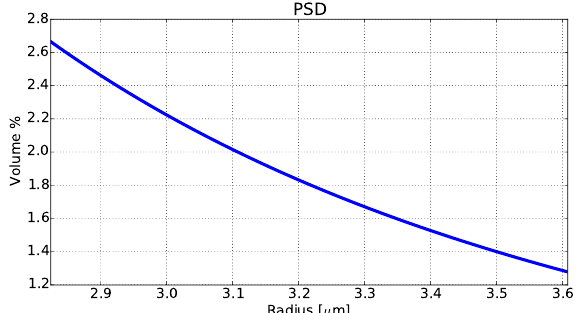
Figure 14. PSD for cylindrical-shaped